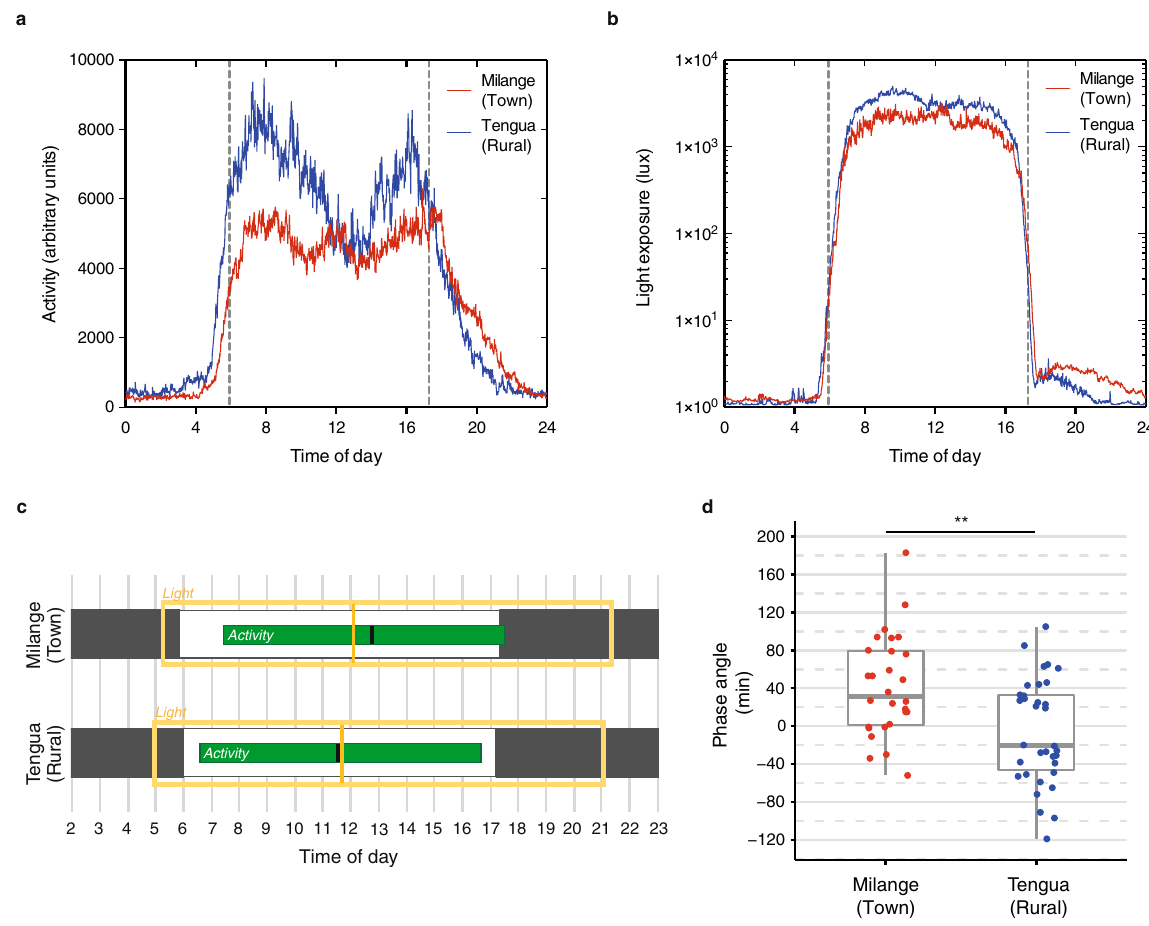
Figure 1. Daily activity and light exposure in rural (Tengua) and town (Milange) settings. Mean 24-h activity ( a ) and light exposure ( b ) profiles for all subjects of Tengua (blue) and Milange (red). Activity (arbitrary units) and light (lux) were measured in 60-s epochs by wrist-worn actigraphy devices. Dashed lines represent mean sunrise (05:55) and sunset (17:18) respectively. ( c ) Representation of the timing of daily activity and daily light exposure in Milange and Tengua based on non-parametric analysis of actigraphy. M10 activity (green bar), centre of gravity of activity (black line), M16 light exposure (yellow box), centre of gravity light exposure (yellow line). Black and white bars represent dark and light periods respectively in the natural environment. ( d ) The phase angle between the centres of gravity of activity and light exposure was significantly different in the two locations, with activity in Milange delayed relative to the light exposure. ** P <